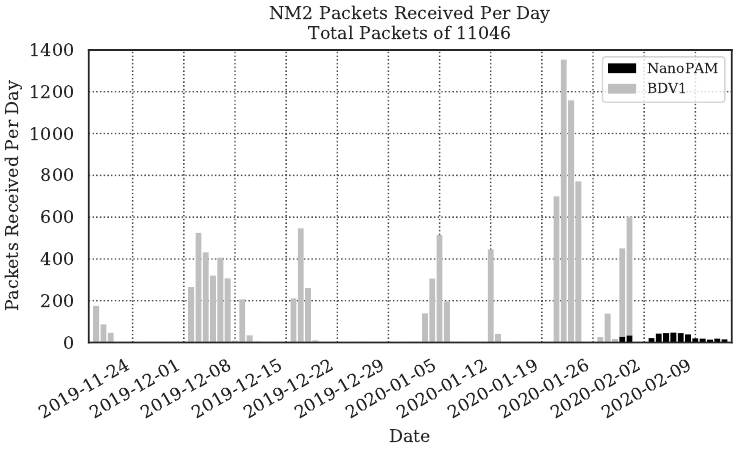
Figure 15. Map of Nodes in North Sea. Two NanoPAM nodes of address 67 and 68. One BDV1 node present from November 2019 to February 2020. One BDV2 node of address 250 present from February 2020 onwards.